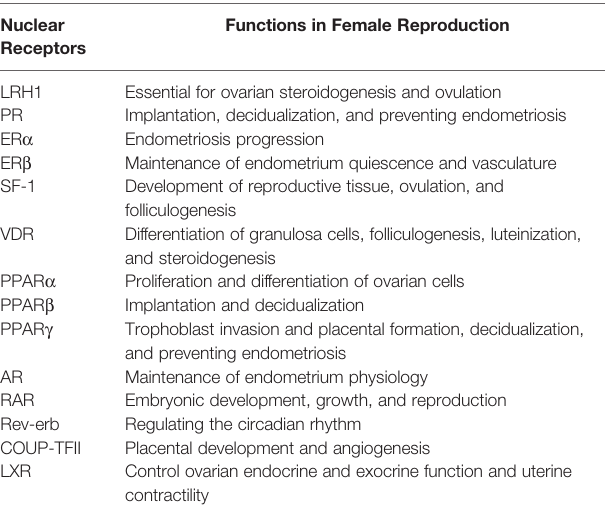
TABLE 3 | Role of Nuclear receptors in female